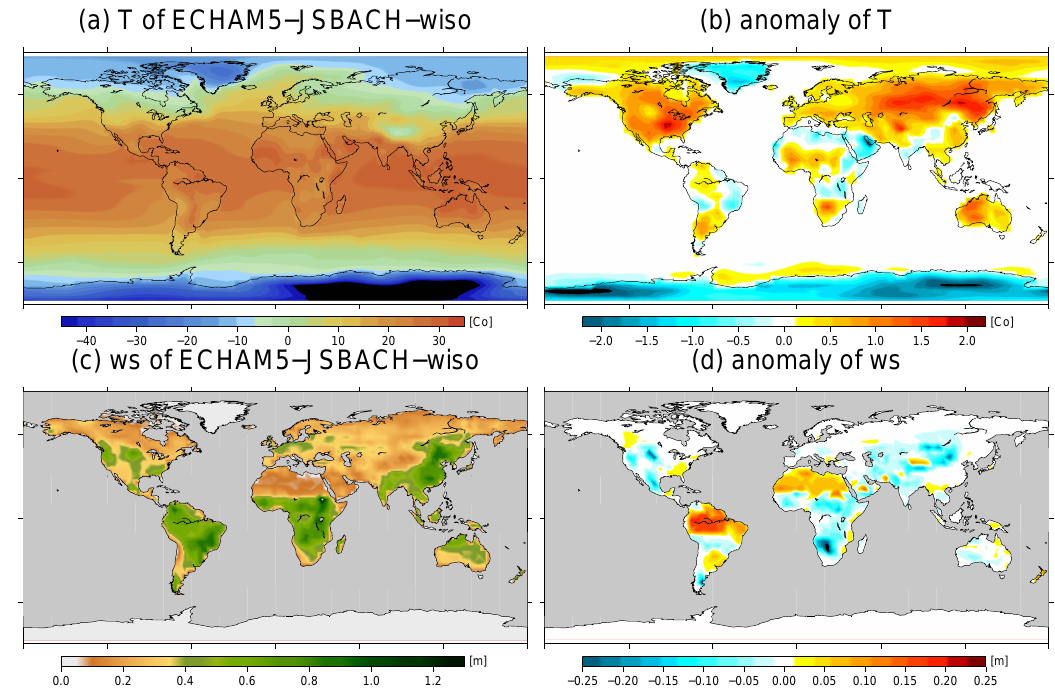
Fig. 1. Comparison of ECHAM5-JSBACH-wiso and ECHAM5-wiso at resolution T31L19: the annual mean values of (a) surface temperature ( T ) and (c) soil wetness (ws) as well as the anomaly between ECHAM5-JSBACH-wiso and ECHAM5-wiso (b) for temperature and (d) for soil wetness.